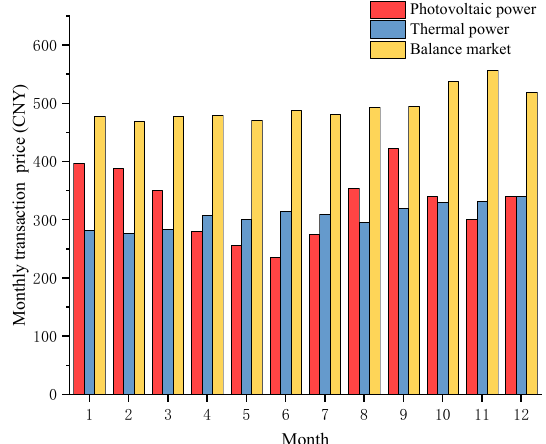
Figure 6. Monthly price in the electricity market.